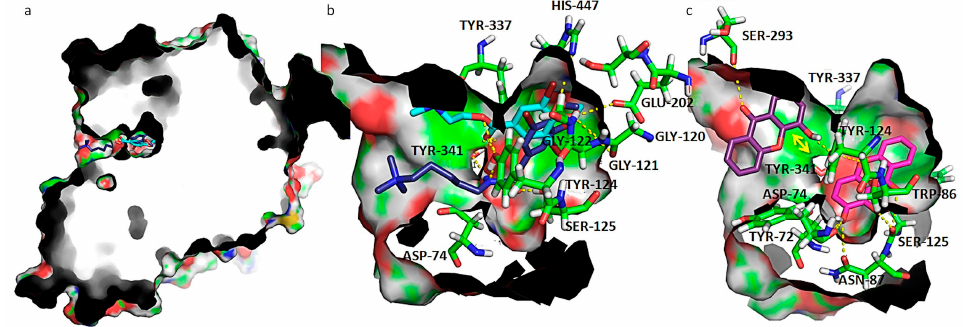
Figure 5. ( a ) Capped surface of AChE, showing the ACh binding pocket with AChE inhibitors pulmonarin A and B (blue sticks); ( b ) detailed view of known antifouling AChE inhibitors: pulmonarin A (light blue sticks) and pulmonarin B (dark blue sticks); ( c ) detailed view of test compounds 4 (purple sticks) and 5 (magenta sticks). Hydrogen interactions are represented with yellow broken line and stacking interactions with a double edge yellow arrow. Residues involved on those interactions are represented as green sticks and labeled. AChE is represented as solid surface, where carbon, hydrogen, oxygen, nitrogen, and sulfur are represented in green, grey, red, blue, and yellow,